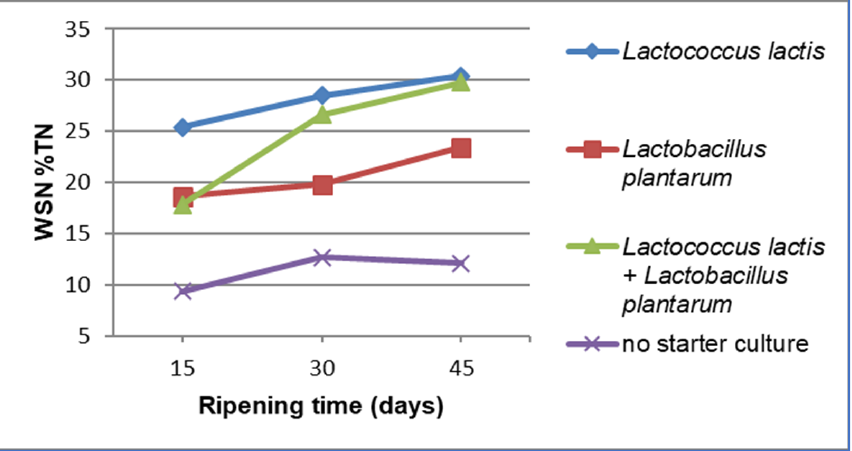
Figure 5. Water-soluble nitrogen fractions in the total nitrogen (WSN %TN) of Sir iz mišine at 15, 30, and 45 days of ripening.